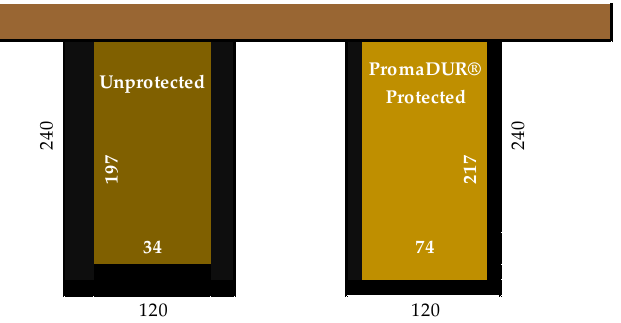
Figure 23. Comparison of the residual cross-section of unprotected and protected beams with Promadur after 45 min of fire exposure.